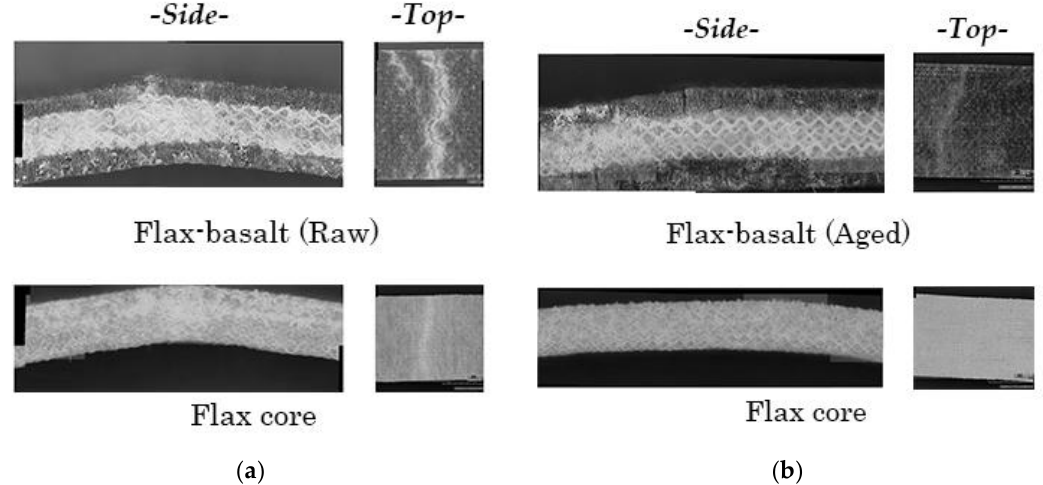
Figure 10. The variation between ( a ) raw and ( b ) 60-day aged basalt/flax hybrid composite in terms of failure mode. Reproduced with permission from [247] .